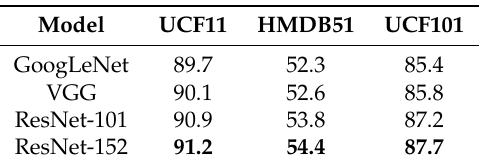
Table 1. Convolutional neural networks (CNNs) encoder analysis on UCF11 and first split of HMDB51 and UCF101. Classification accuracy is used as evaluation measure which represented as recognition accuracies (%). The bold text represents the best result.